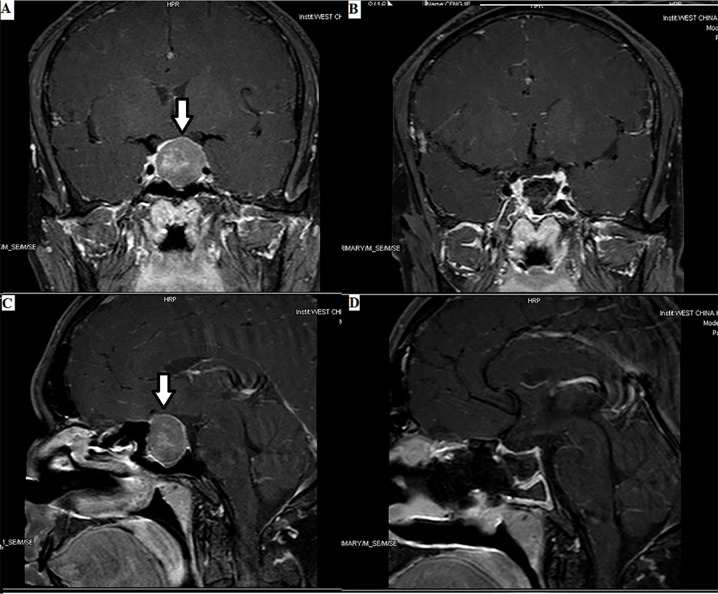
Enormous TSH PitNET: 1. Preoperative magnetic resonance imaging (MRI) (A, C): solid tumor occupying the saddle area, with a size of 1.8×2.4×2.5 cm, as indicated by the arrows. 2. Postoperative MRI (B, D): low signal shadow in the sella region.